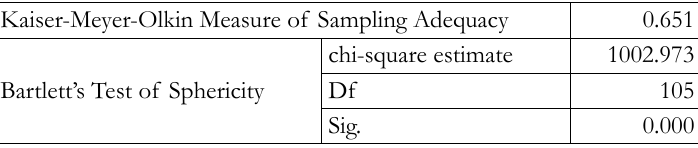
Table 5. Bartlett’s Test and Kaiser-Meyer-Olkin (KMO) measure